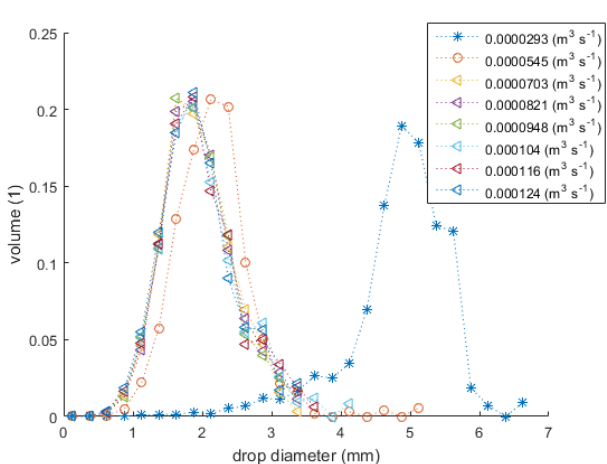
Fig. 4. Droplet generator - drops size distribution based on volume [6] .